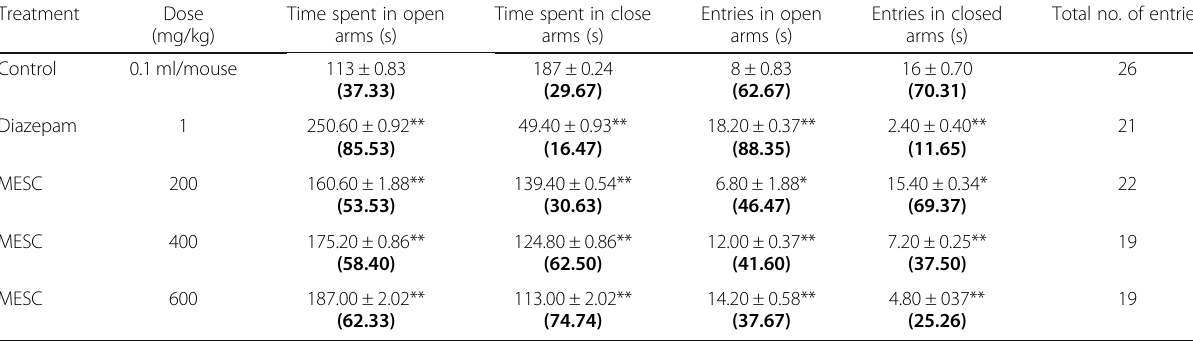
Table 4 The anxiolytic effect of MESC on elevated plus-maze test in mice Treatment Dose